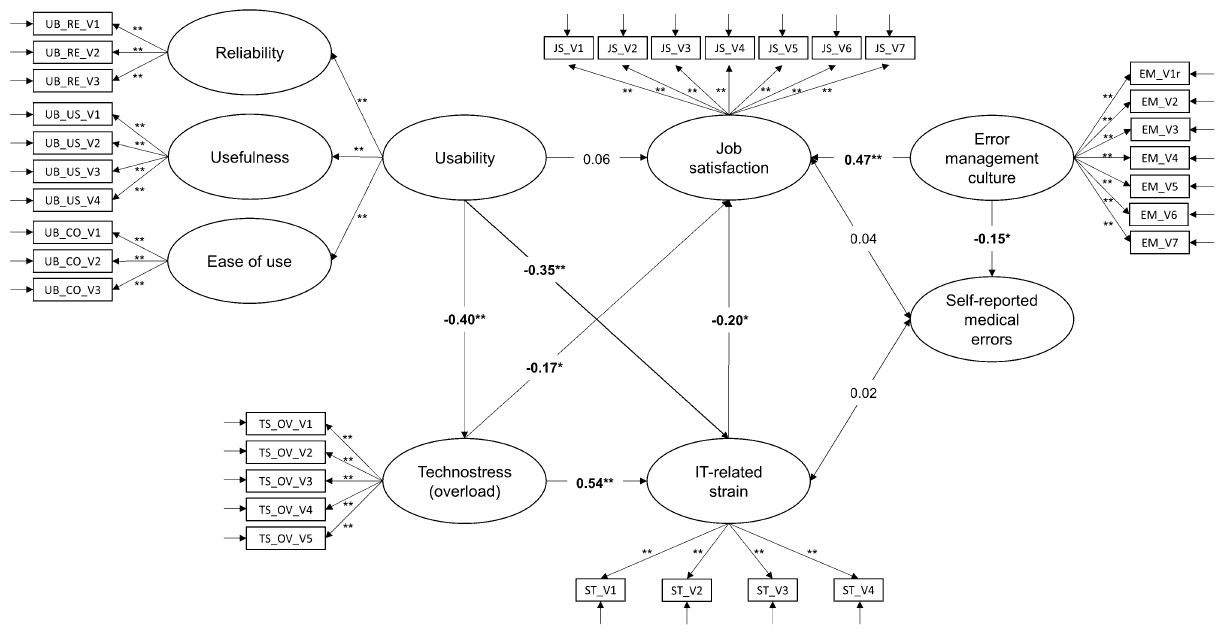
Figure 4. Structural equation model (measurement and structural model), N = 445, * p < .050, ** p <